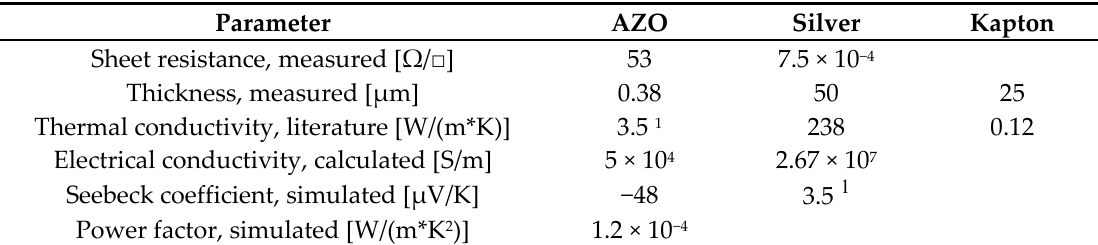
Table 1. Parameter values used in the simulations.